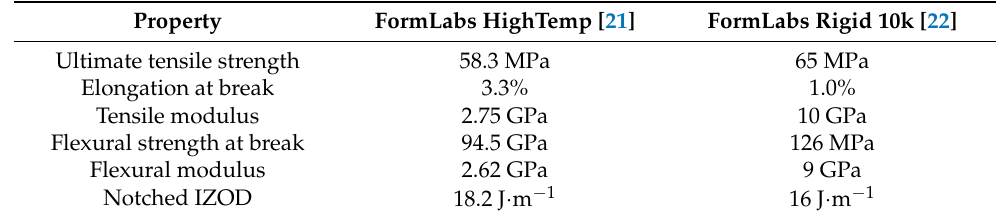
Table 1. Mechanical properties of Formlabs HighTemp and FormLabs Rigid 10k resins. Property FormLabs HighTemp [21] FormLabs Rigid 10k [22] Ultimate tensile strength 58.3 MPa 65 MPa Elongation at break 3.3% 1.0% Tensile modulus 2.75 GPa 10 GPa Flexural strength at break 94.5 GPa 126 MPa Flexural modulus 2.62 GPa 9 GPa Notched